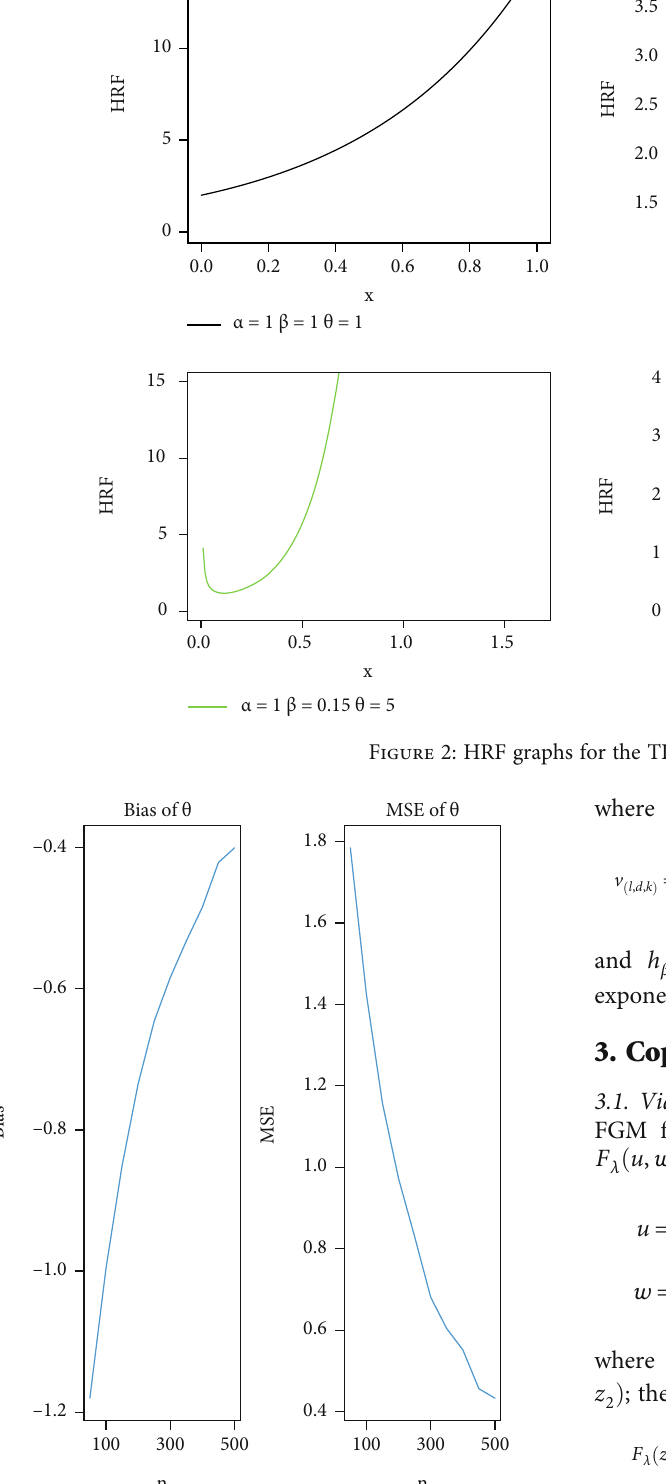
Figure 3: Biases and MSEs for the parameter α